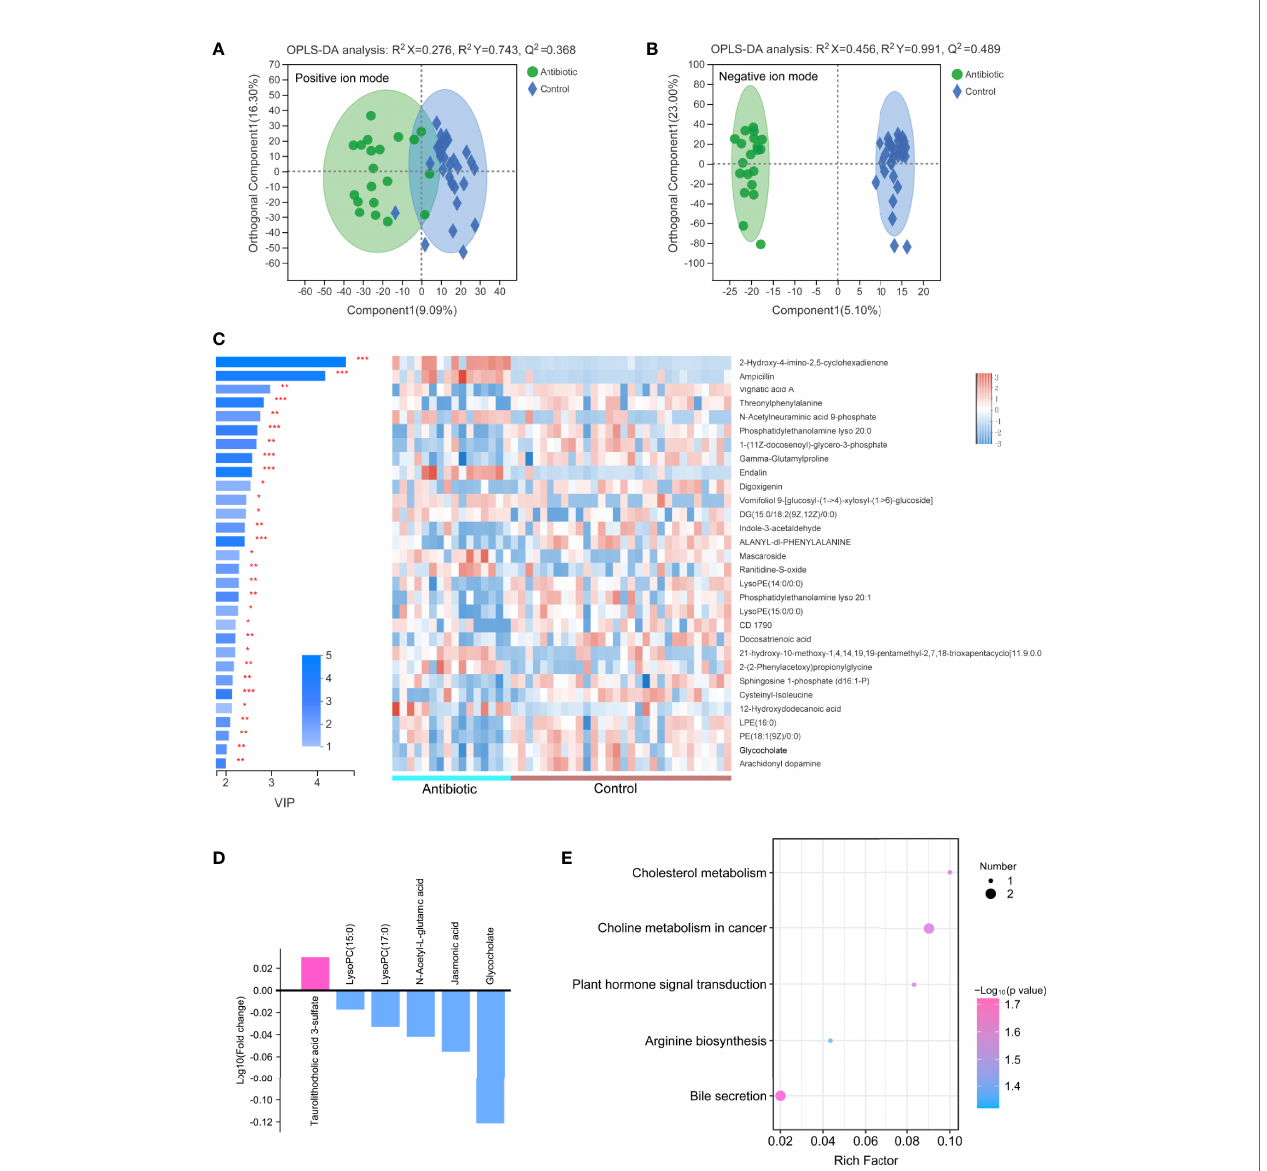
FIGURE 5 | OPLS-DA models of the metabolites between the antibiotic group and control group in positive ion mode (A) and negative ion mode (B) . The variable importance in the projection generated in the OPLS-DA analysis between the antibiotic group and control group in negative ion mode (C) . (D) Log 10 fold-change of the metabolites involved in cholesterol metabolism, plant hormone signal transduction, arginine biosynthesis, bile secretion, and choline metabolism in cancer pathways. (E) Enriched pathways between the antibiotic group and control group in negative ion mode. “ * ” meansP values smaller than 0.05; “ ** ” means P values smaller than 0.01; “ *** ” means P values smaller than